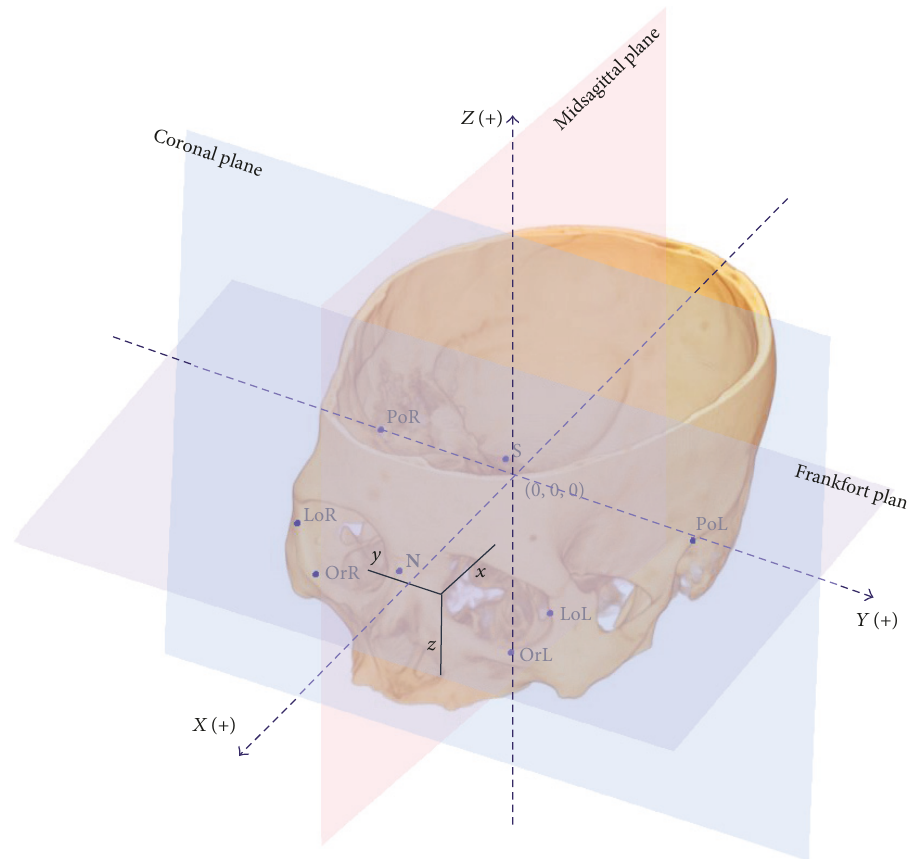
Figure 1: The landmarks and reference coordinate system. PoR = right porion; PoL = left porion; OrR = right orbitale; OrL = left orbitale; N = nasion; S = sella; LoR = right lateral orbital point; LoL = left lateral orbital point. The positive x , y , and z coordinate values indicated the front, left, and superior orientation,